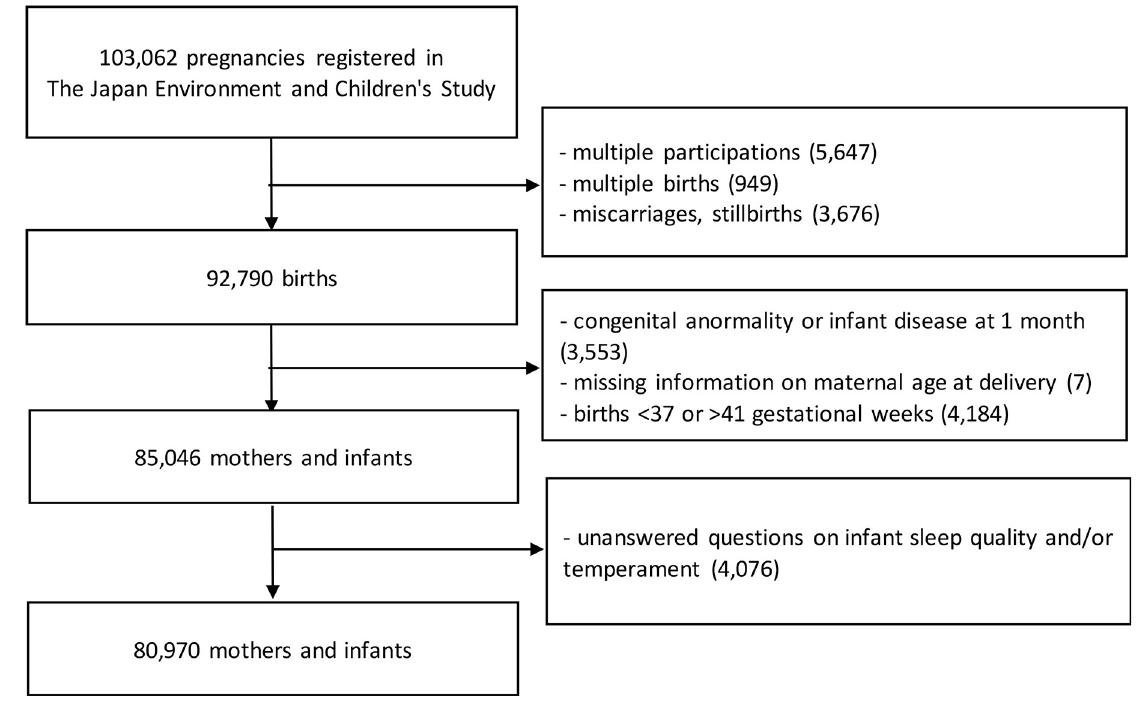
Fig 1. Flow diagram of the selection process of study